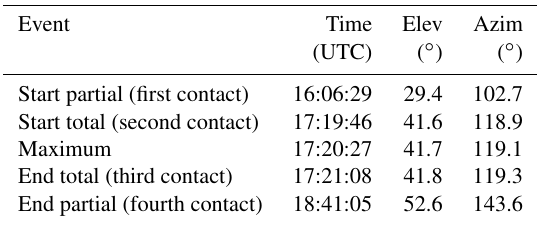
Table 1. Times and solar elevation, azimuth for different character- istic events of the eclipse of 2017 at the measurement position. El- evation is given relative to the horizon, azimuth is measured clock- wise from the north (JPL convention). Created with use of Espenak (2018).